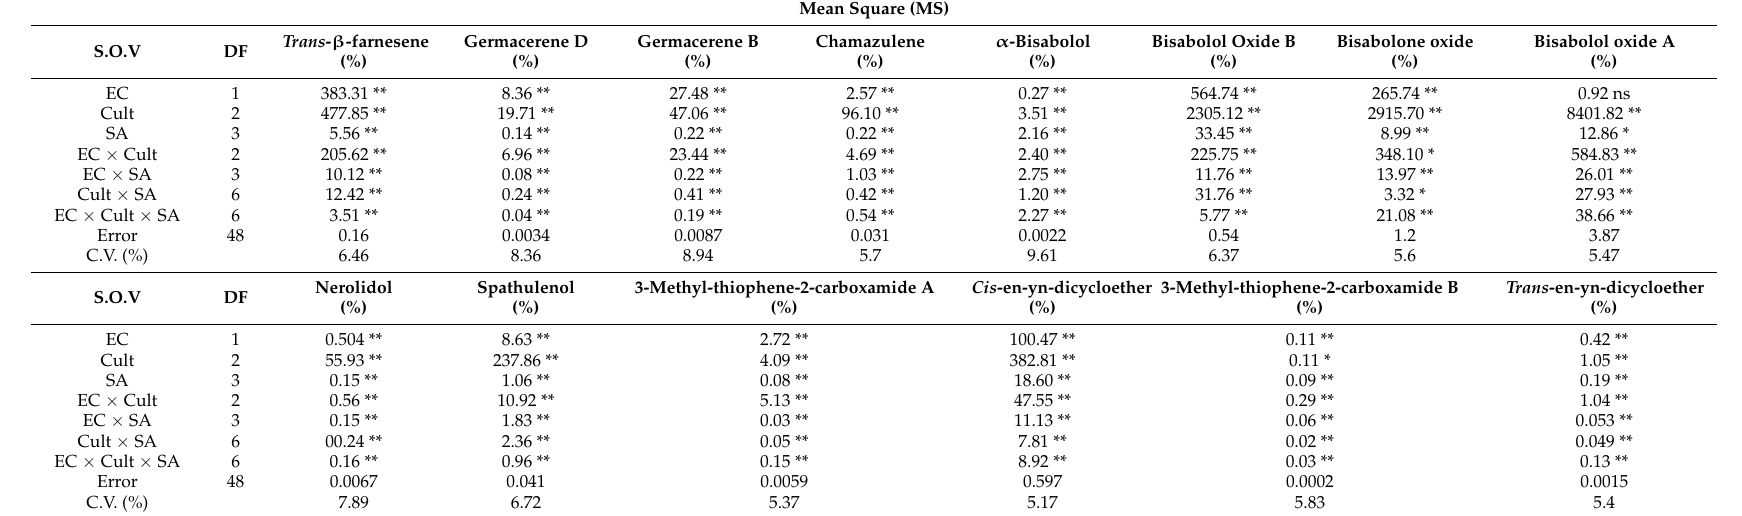
Table 2. Analysis of variance for identified chemical compounds of German chamomile cultivars treated with salicylic acid under normal and heat stress conditions. Mean Square